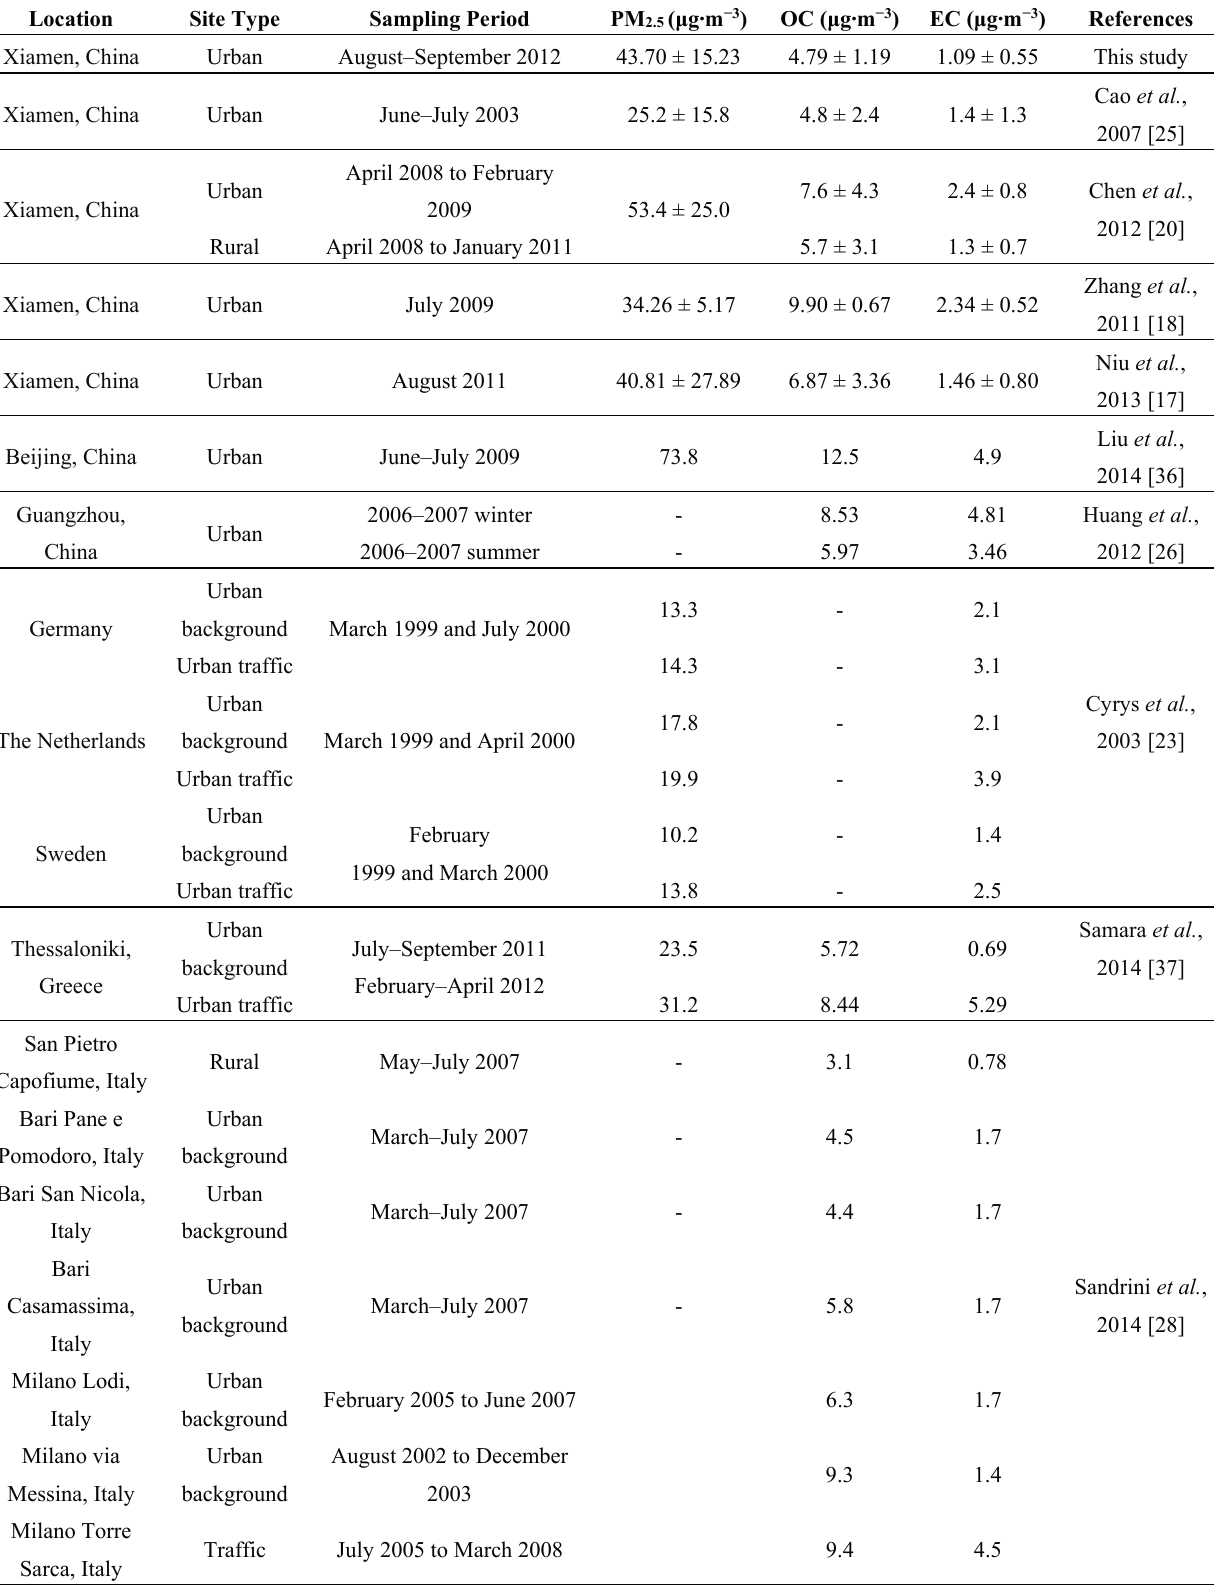
Table 7. Comparison with data from previous